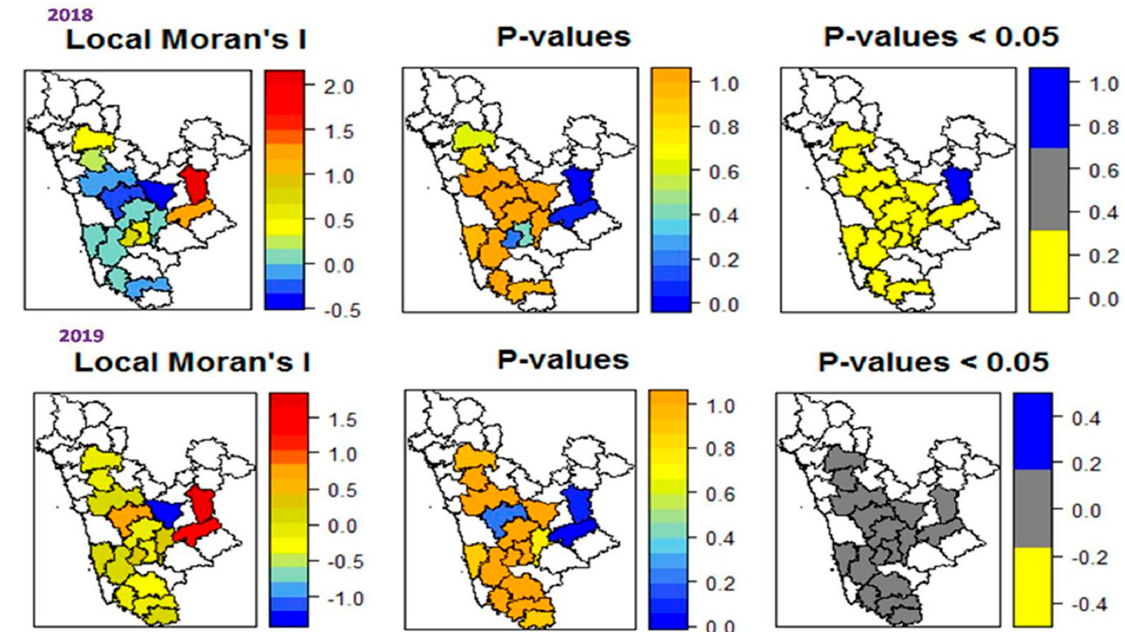
Figure 3. Local Moran’s I clusters across the studied areas in Karnataka, as inferred from p -values ( p < 0.05), portraying higher, medium, and lower spatial rates of dependency.